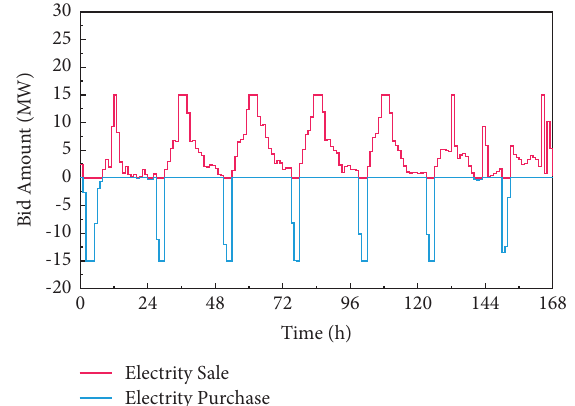
Figure 12: Optimal scheduling situation of interruptible